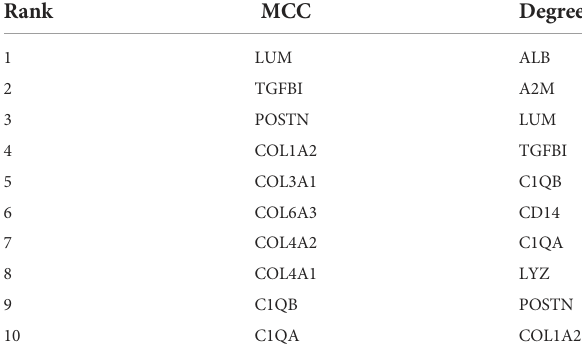
TABLE 2 The top 10 EP-DEGs ranked by MCC and Degree method using the CytoHubba plug-in via Cytoscape. Rank MCC